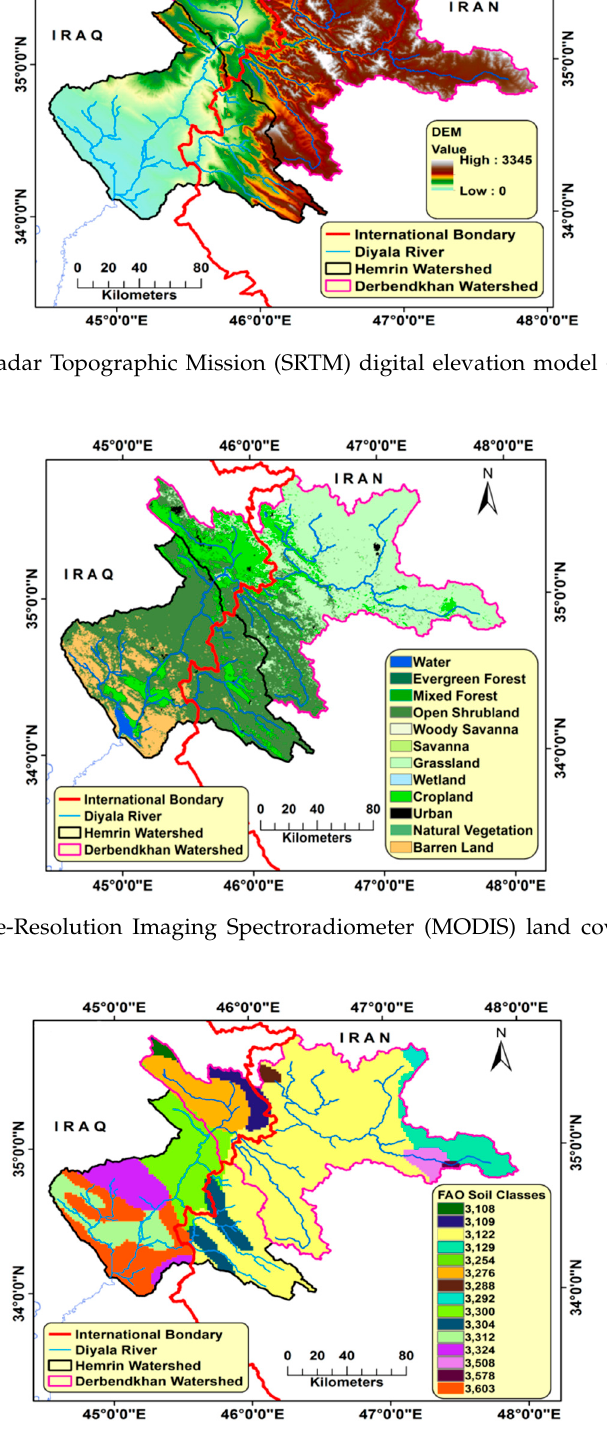
Figure 4. FAO soil data applied into SWAT.